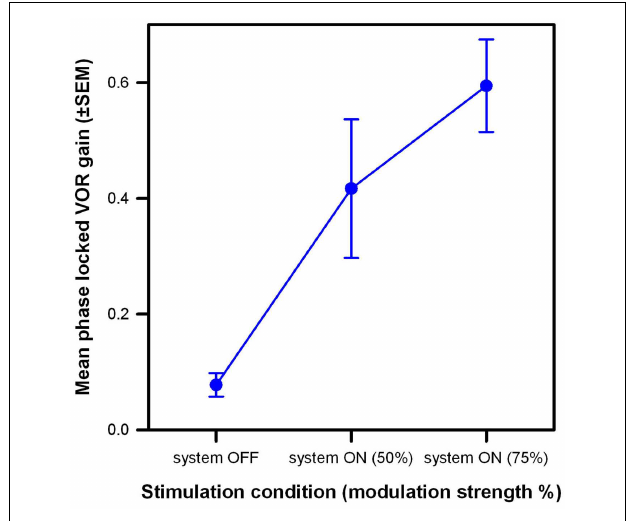
FIGURE 6 | Mean phase-lockedVOR gain ( ± SEM) versus stimulation condition of the three implanted patients .Three stimulation conditions are compared: system OFF and system ON with modulation strengths corresponding to 50 and 75% of each patient’s dynamic range. Rotations had a 30°/s peak-velocity sinusoidal profile (around the vertical axis) at 1Hz.